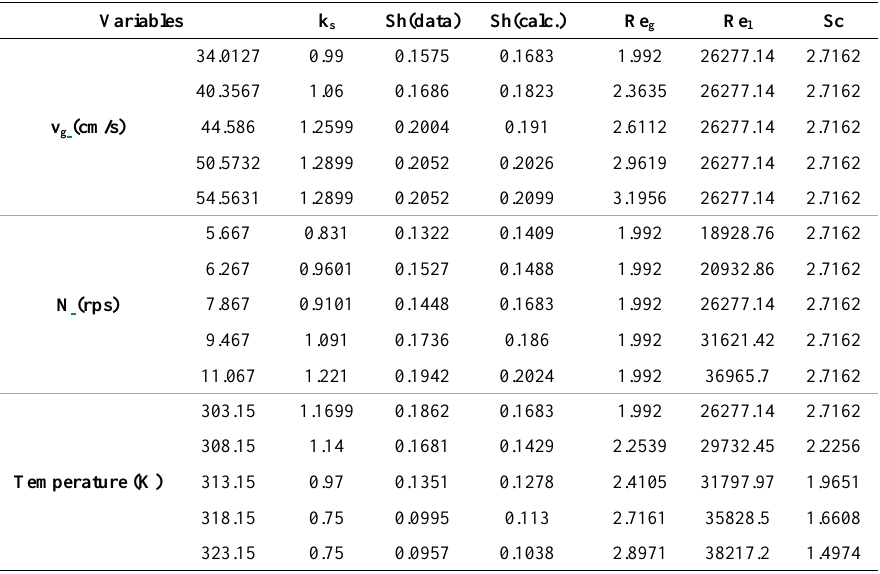
Table 4. Relationship between Sh (experimental data and calculation), Re g , Re l , and Sc on various k s values